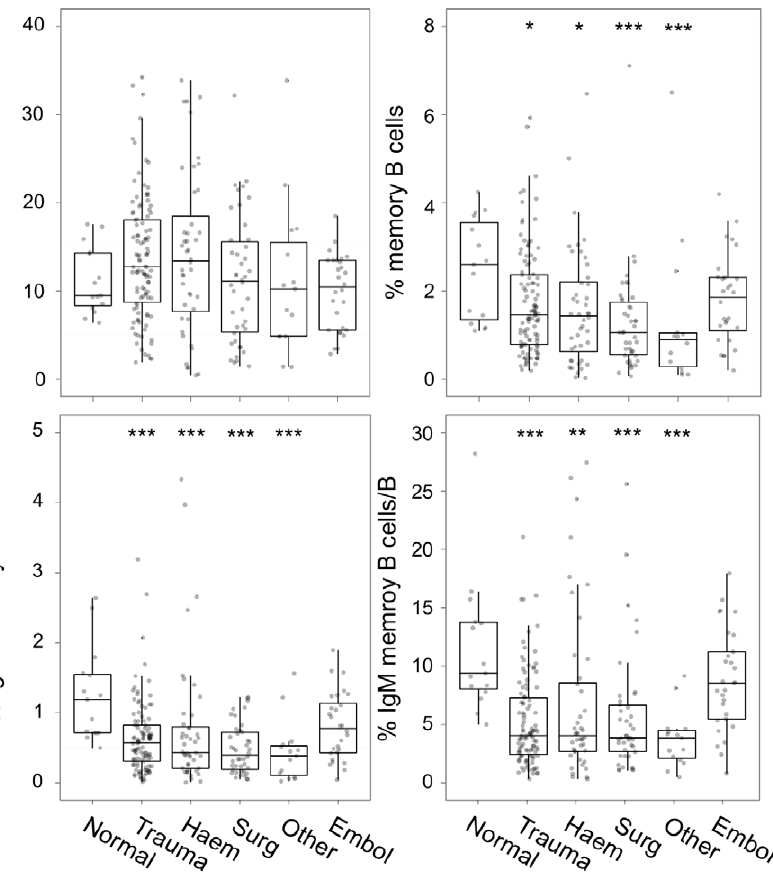
Figure 3. Distribution of B cell subsets in normal and hyposplenia individuals by indication for splenectomy. Subjects were classified by indication for splenectomy and compared to normal laboratory controls (n=15). Normal=normal controls, Trauma=splenectomy related to trauma, Haem=haematological disease, Surg=splenectomy incidental to abdominal surgery, Embol=splenic embolization. Box-plots show the median as the horizontal line in the middle of the box, 25% as the lower end of the box 75% as the upper end and whiskers show the range. Bonferroni corrected p values determined by Wilcoxon non-parametric statistic * , 0.05, ** , 0.001, *** , 0.0001 for comparisons to normal controls.